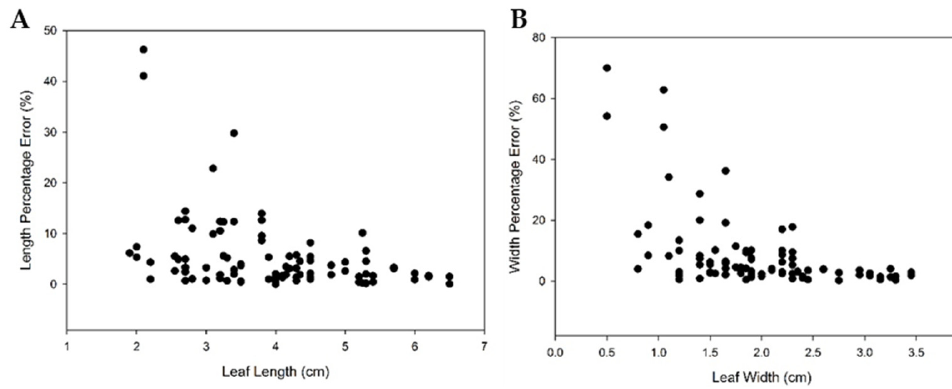
Figure 8. Percentage error by leaf size: ( A ) leaf length and ( B ) leaf width.